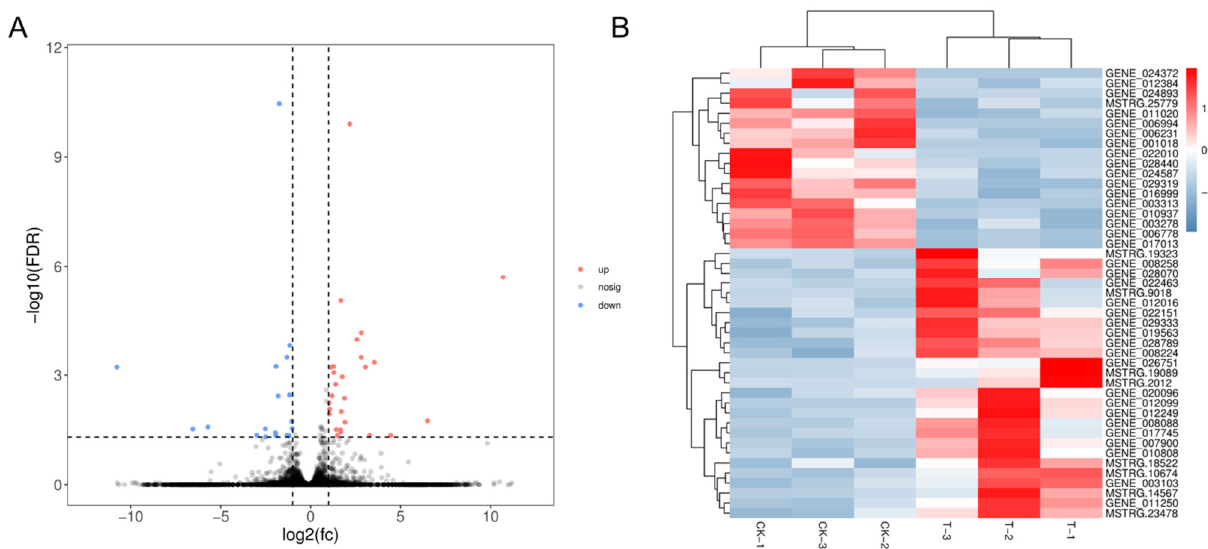
Figure 7. Effects of 5-AzaC treatment on the transcriptome of sporophytes. ( A ) The volcano plot of different expression genes (DEGs) present, in which blue dots indicate down-regulated genes and red dots indicate up-regulated genes in response to 5-AzaC treatment. ( B ) Cluster analysis of differential expression genes. Each row represents one DEG, and the color gradually changes from blue to red, indicating the shift of gene expression level from low to high. CK represents the control group, and T represents the 5-AzaC treatment group.